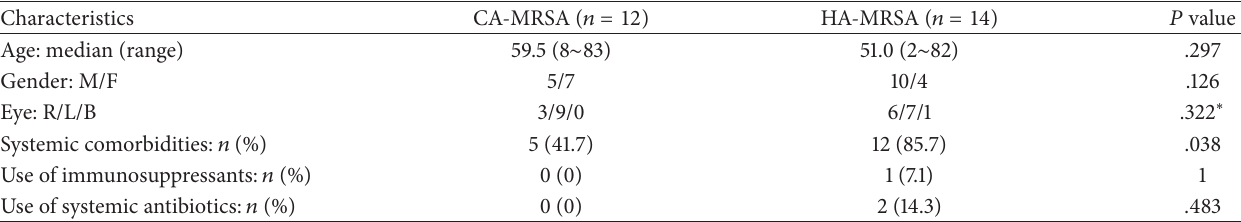
Table 1: Comparison of demographics and characteristics of the patients with community-associated methicillin-resistant Staphylococcus aureus (CA-MRSA) and healthcare-associated methicillin-resistant Staphylococcus aureus (HA-MRSA) keratitis. Characteristics